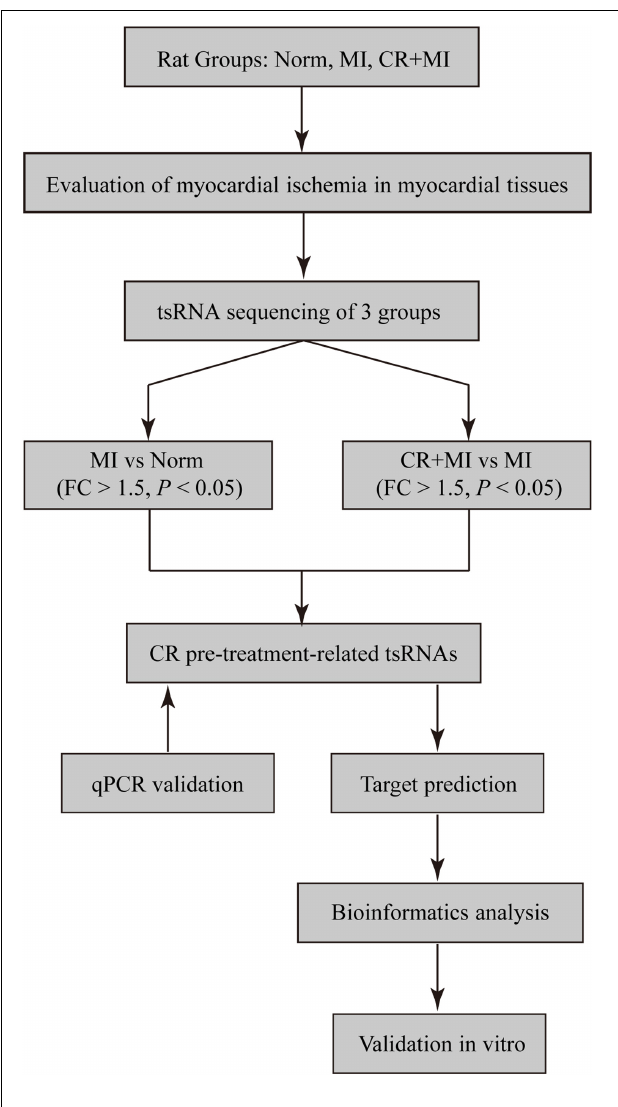
FIGURE 1 | Study design. Norm, normal control group; MI, isoproterenol-induced myocardial ischemic group; CR, caloric restriction; CR + MI, CR pretreatment plus ISO-induced myocardial ischemic